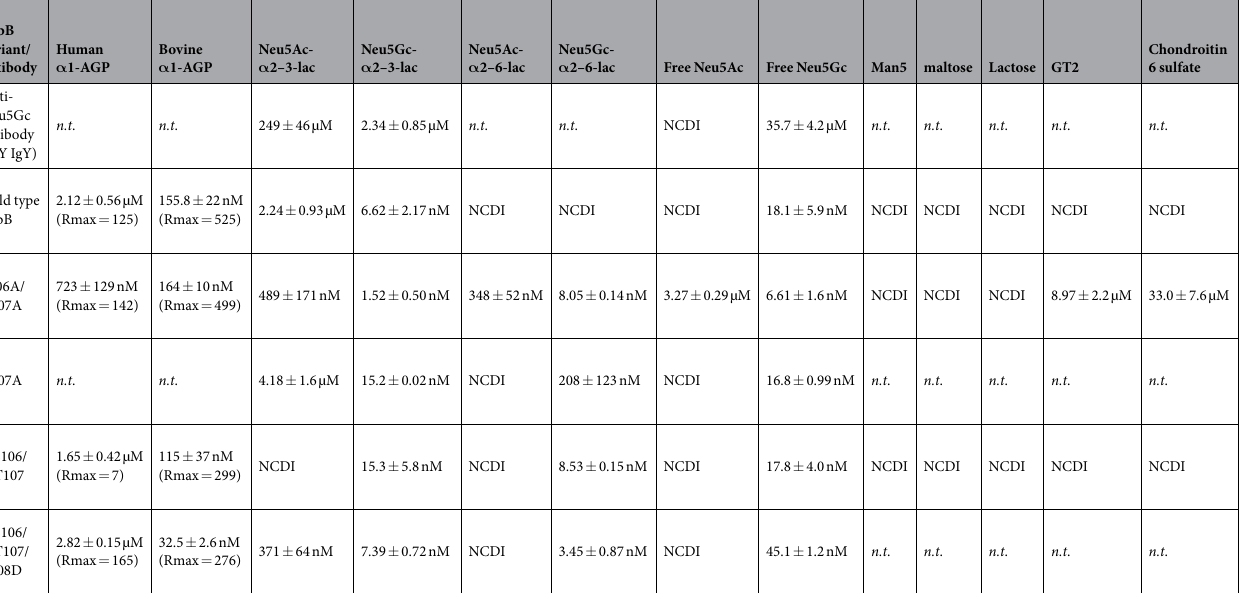
Table 1. Surface Plasmon Resonance analysis of Neu5Gc binding proteins. Binding affinities of wild type SubB, various mutant derivatives and an anti-Neu5Gc IgY antibody, to purified tri- and monosaccharides and/ or human or bovine α 1-acid glycoprotein (AGP) was determined by SPR, as described in the Materials and Methods. NCDI indicates that no concentration- dependent interaction was observed with concentrations ranging up to 100 µ M; n.t .: Not tested; Rmax: the total amount of response units (RUs) of the analyte bound to the protein (the higher the number the more the glycan/glycoprotein was bound by the immobilised